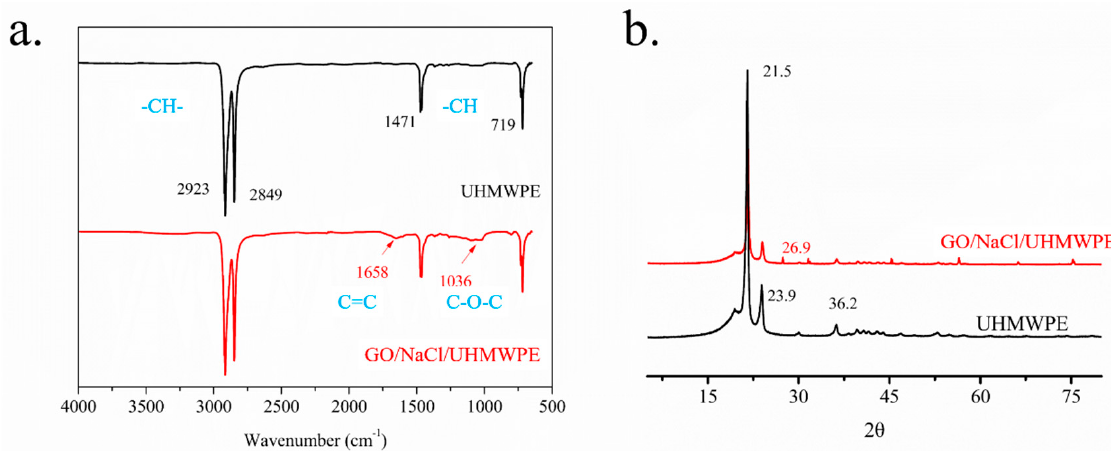
Figure 5. Characterization of the chemical structure of UHMWPE and surface porous GO/NaCl/UHMWPE composites with 1 wt.% GO and 10 wt.% NaCl. ( a ) FT-IR spectrum; ( b ) XRD spectrum.